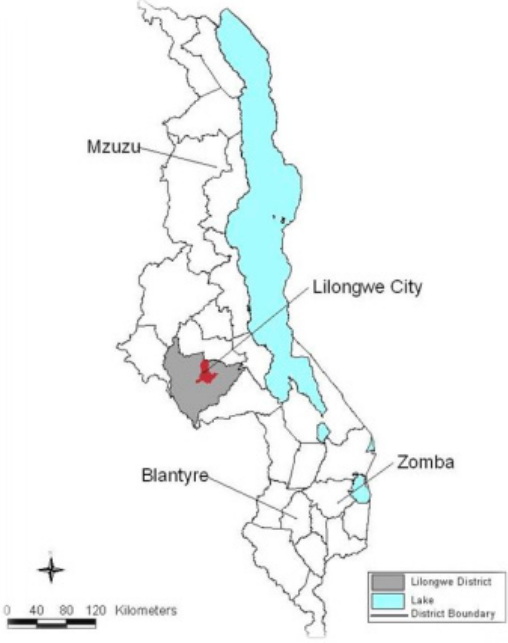
Figure 1. Map of Malawi showing the location of Lilongwe and other cities.